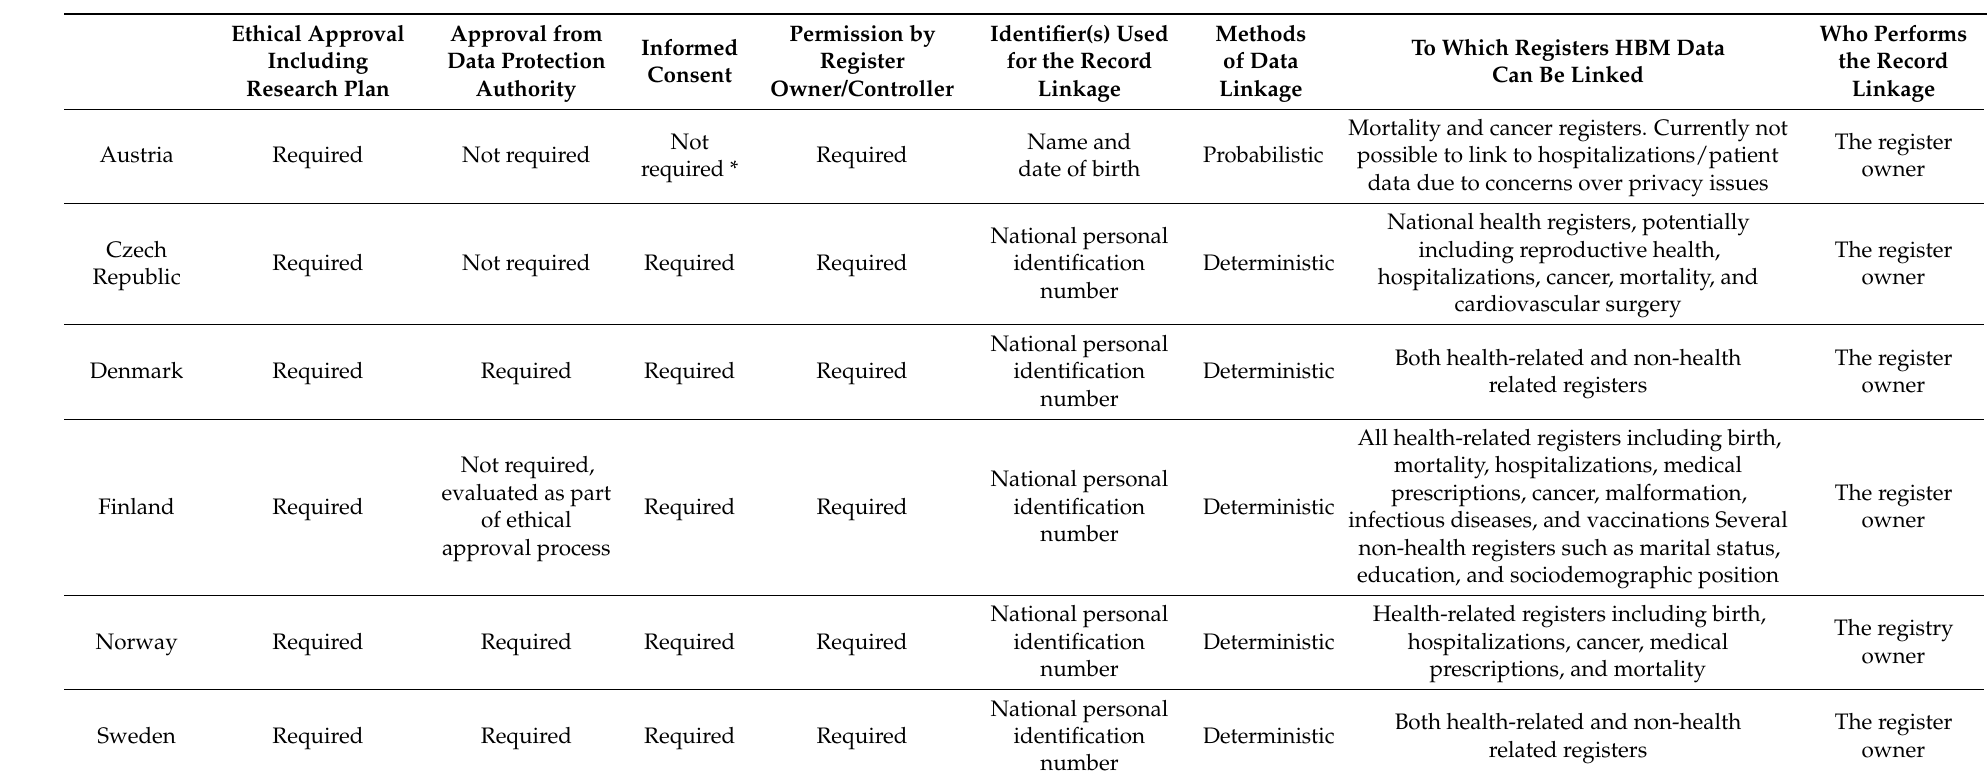
Table 1. Example of procedures for record linkage in six